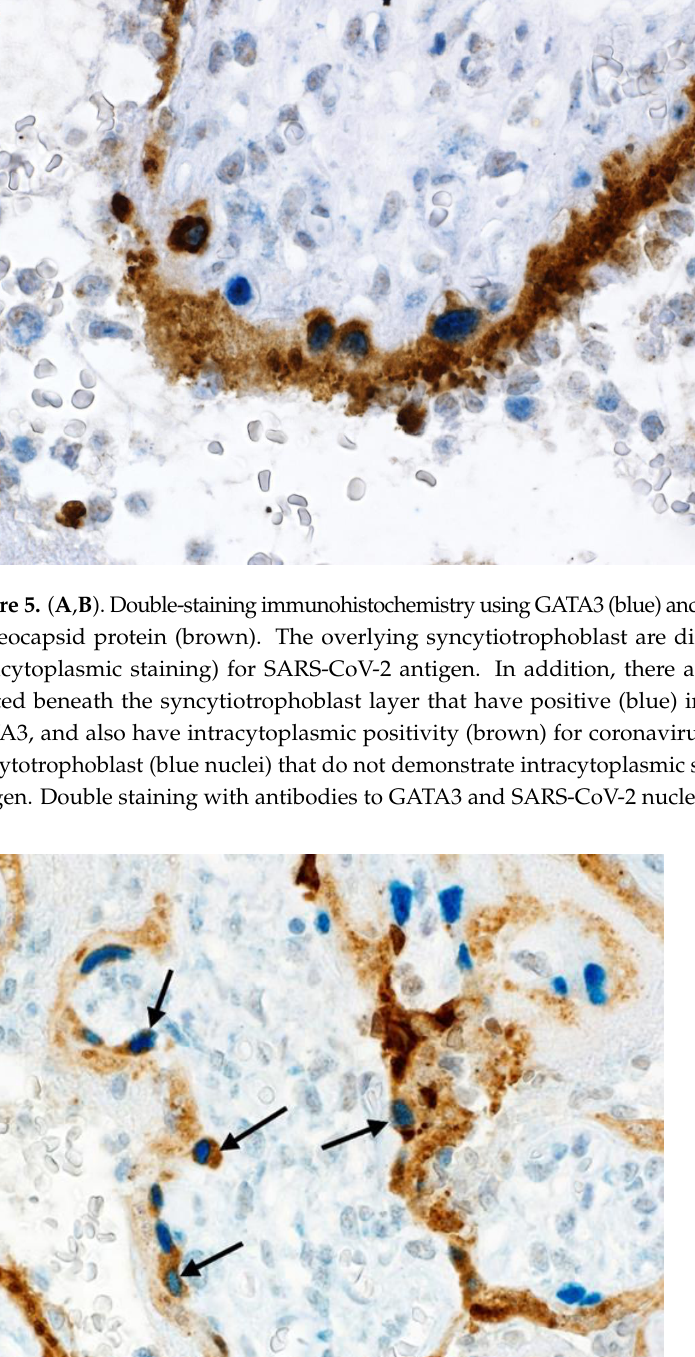
Figure 7. In this double-stained preparation the nuclei of the intermediate trophoblast stain posi- tively (blue) using antibody to GATA3, but the cells are negative for viral staining using antibody to SARS-CoV-2 nucleocapsid protein. Syncytiotrophoblast in the surrounding chorionic villi stain positive (brown) for viral antigen. Double staining with antibodies to GATA3 and SARS-CoV-2 nu- cleocapsid protein, ×10.